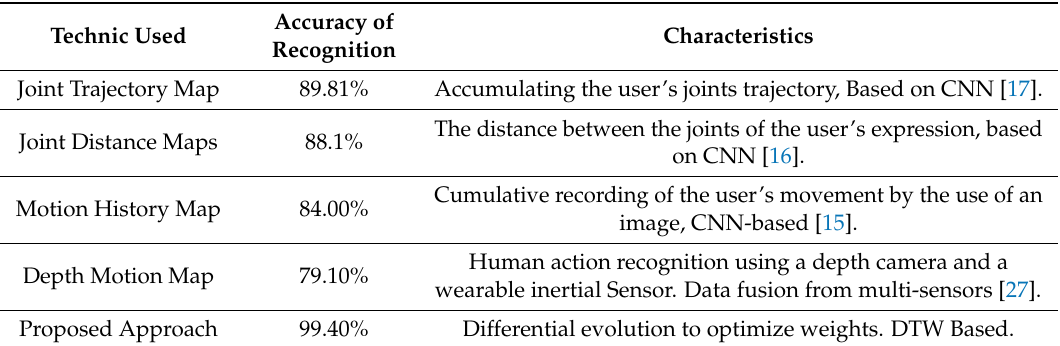
Table 2. Experimental results on